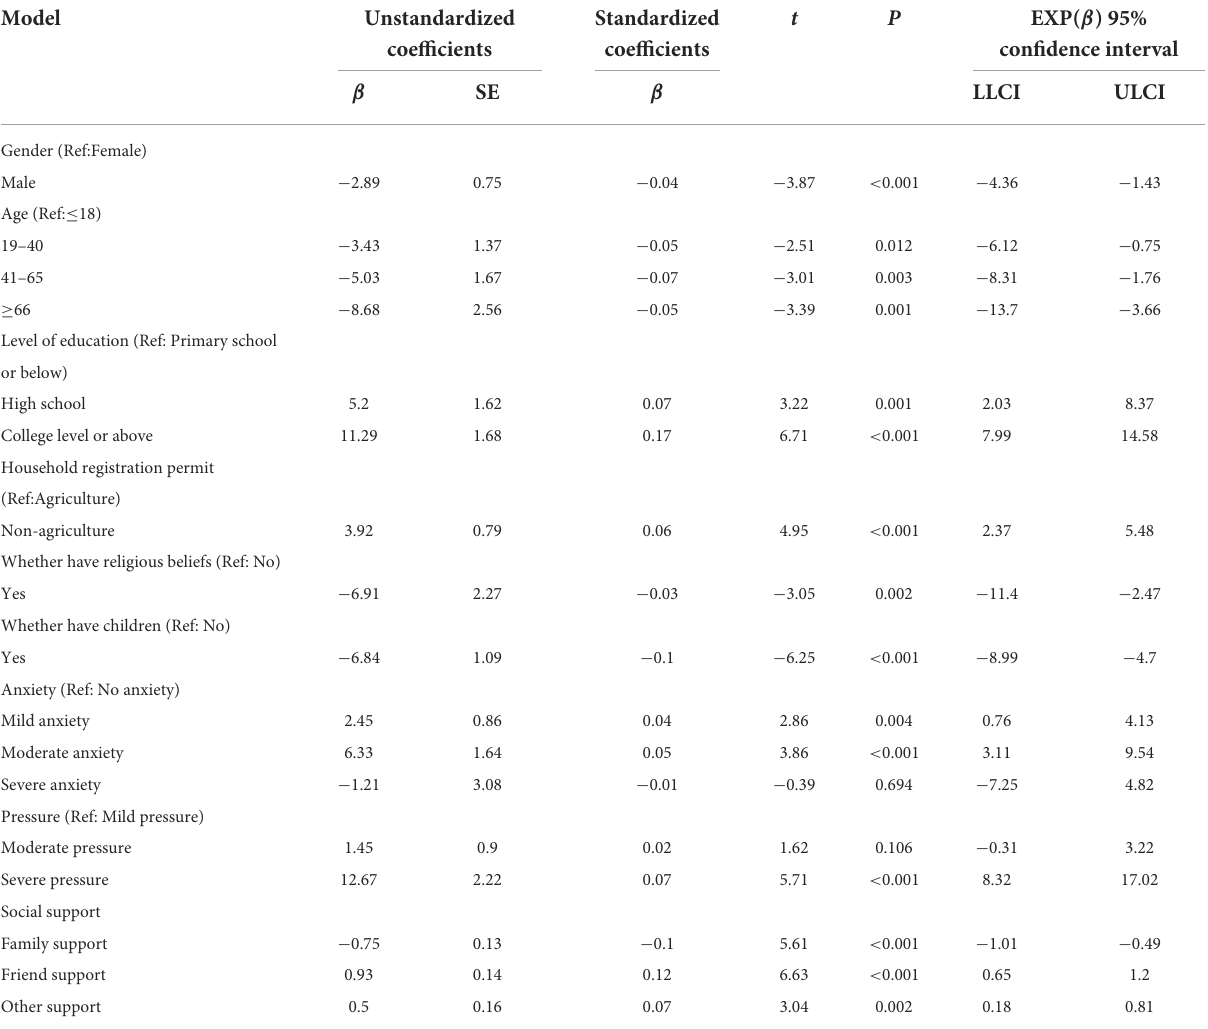
TABLE 6 Regression model of accept willingness to organ donation among ordinary media users. Model